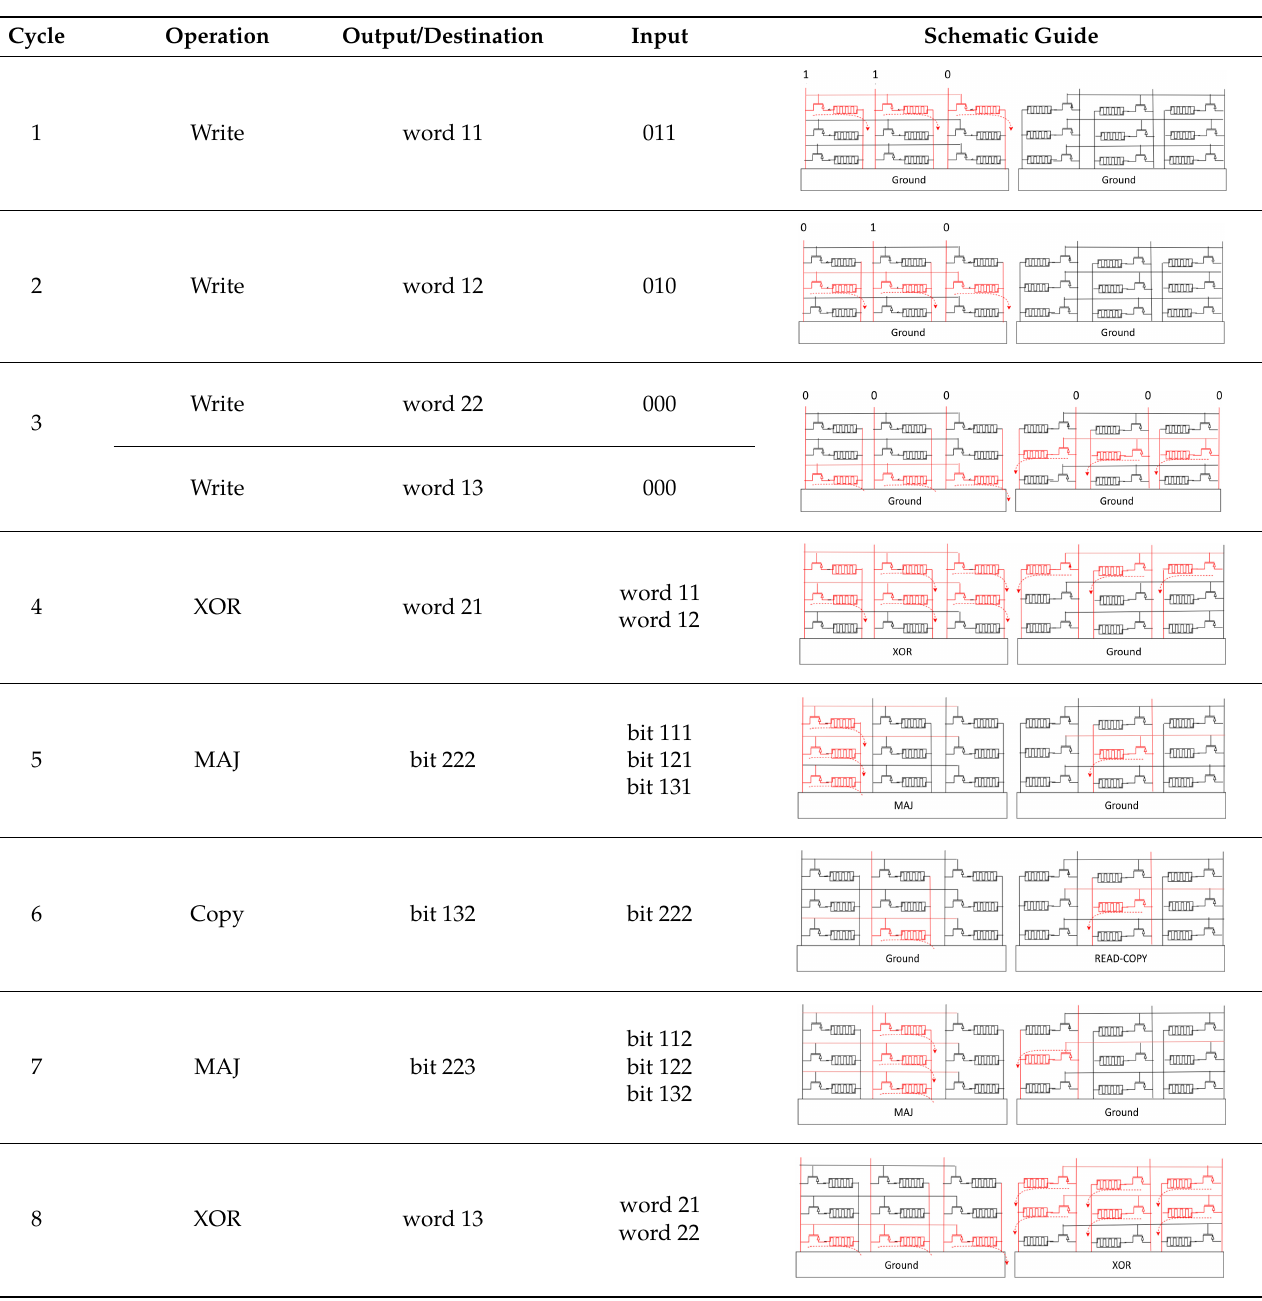
For each one of the eight total simulated cycles described in Table 3, we present in Table 4 the corresponding form of the system instructions that are executed. We sepa- rated in different columns all the different fields explained in Figure 9. The different colors in the values given for input/output addresses designate the different fields of the address code in Figure 9a: red for the crossbar N o bit, orange for the Wordline Selection bits, blue for the Bitline Selection bits, and purple for the bit which defines bit-/word-wise operation. For instance, in the eighth cycle, we perform an XOR (opcode = “0100”) in crossbar 2 (crossbar N o bit = 1) with the contents of word 1 and word 2 (wordline selec- tion bits = “01”/”10”) on all bitlines (bitline selection bits = “00”), as reflected in the input addresses. The result is stored simultaneously (mode bit = 1) without any logical shift